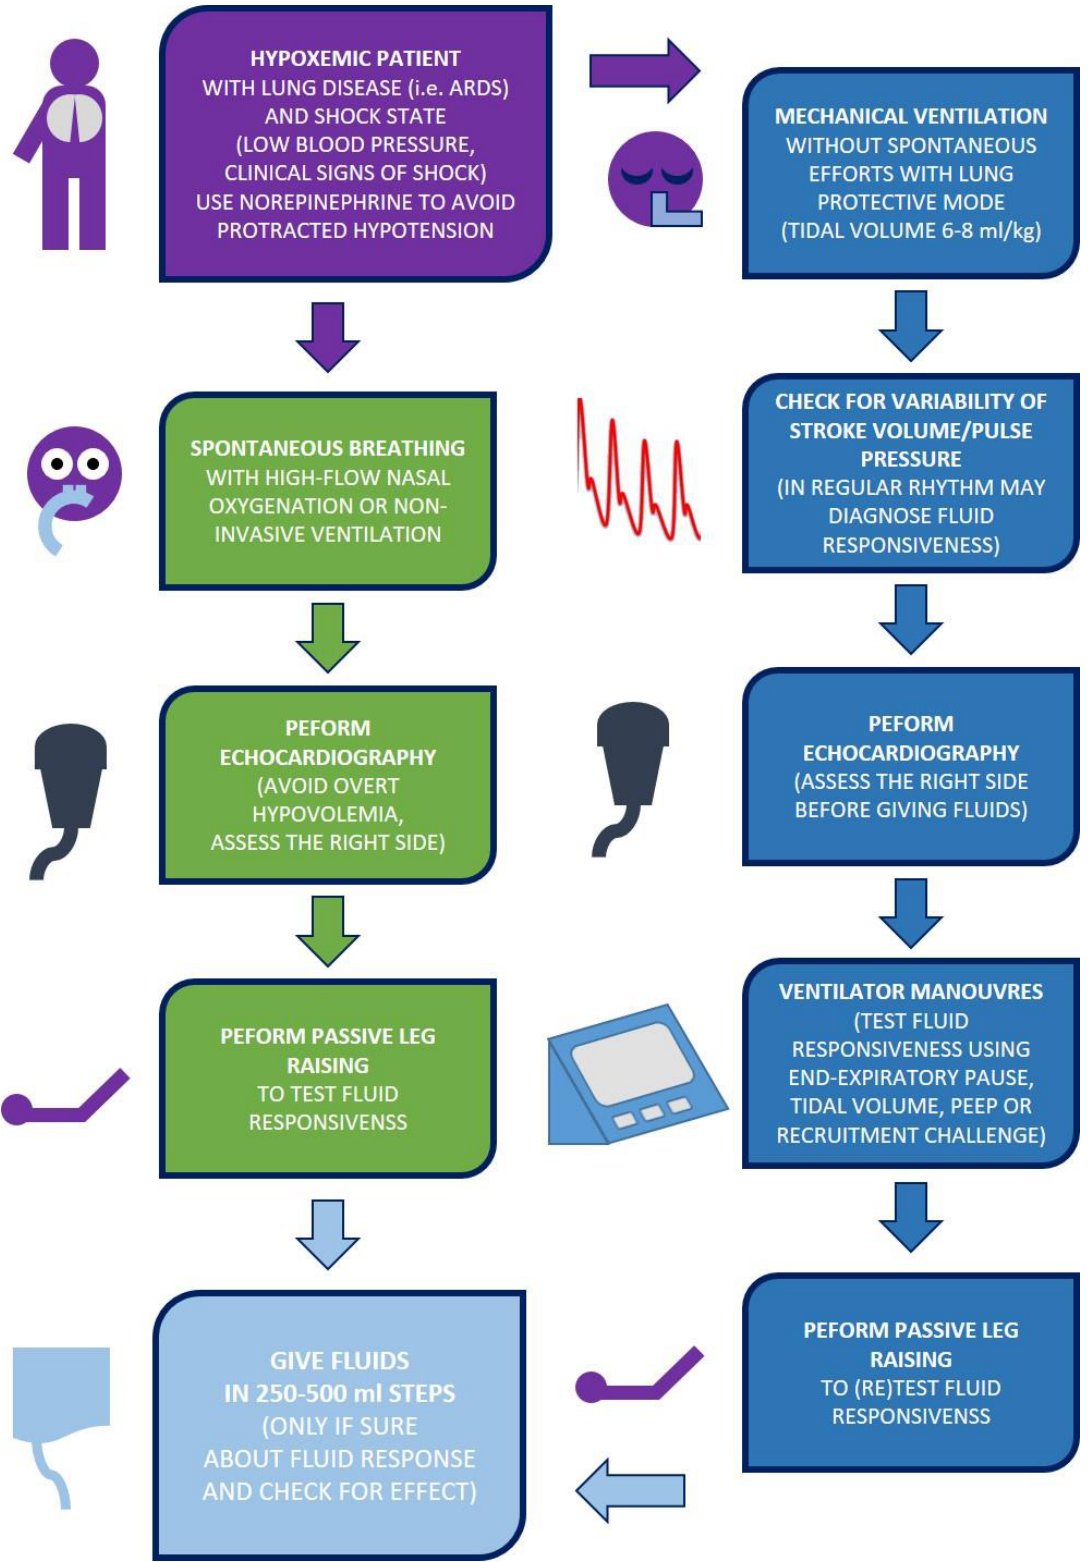
Figure 2. The simplified schematic approach to fluid therapy in patients with lung involvement during the resuscitation and optimization phase.